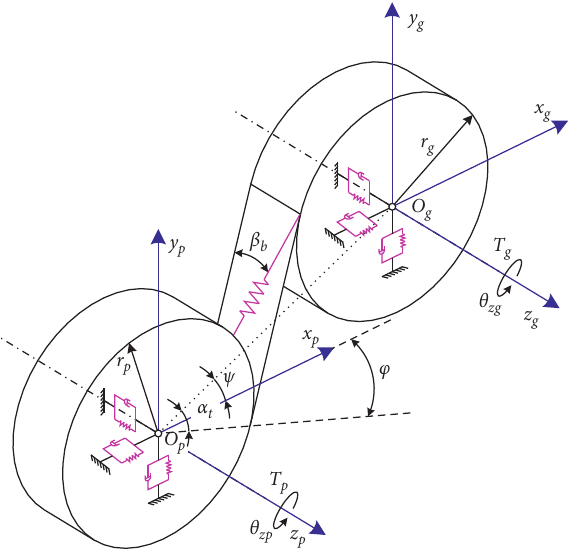
Figure 9: Dynamic model of a helical gear